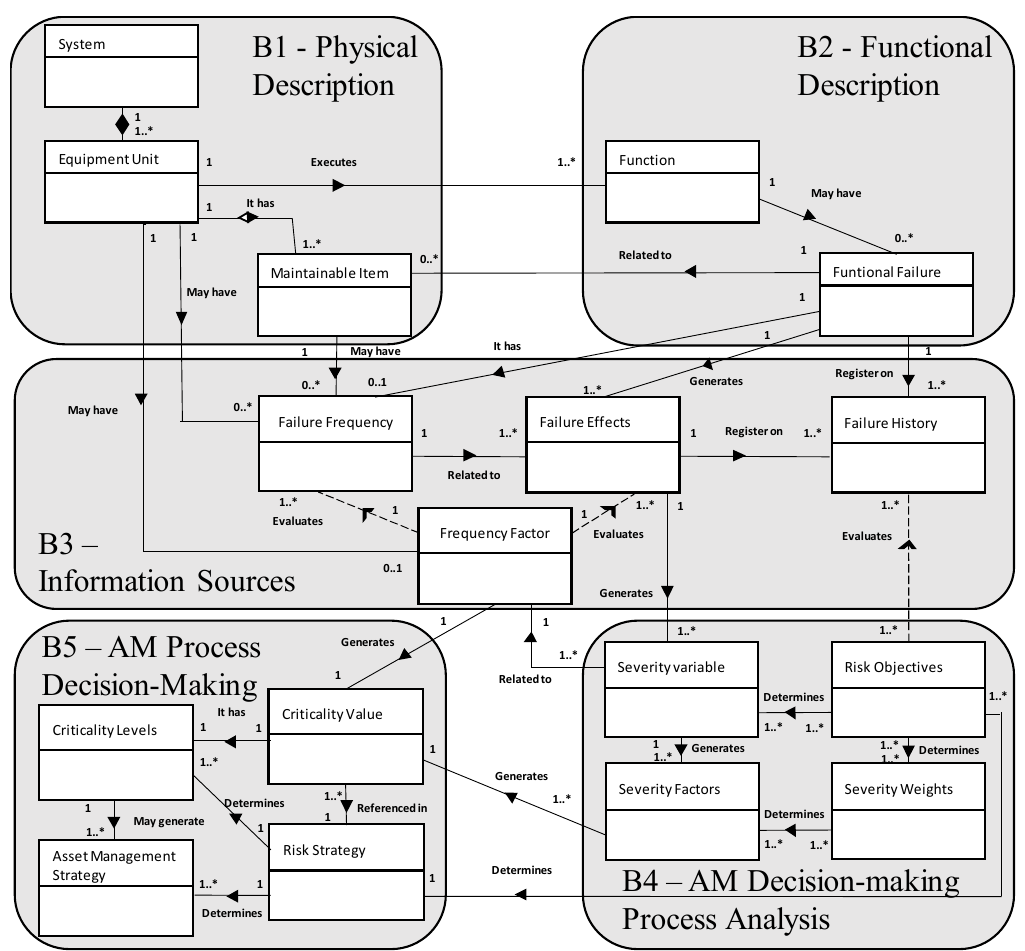
Figure 11. Energies 2020 , 13 , x FOR PEER REVIEW